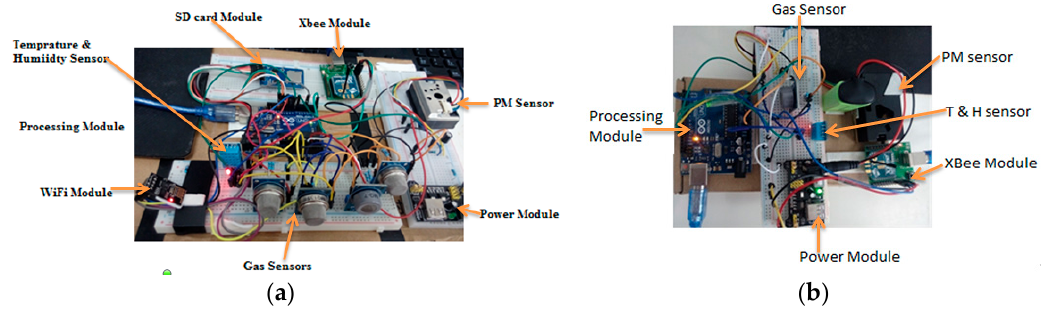
Figure 4. ( a ) ECD module. ( b ) Sensing module.